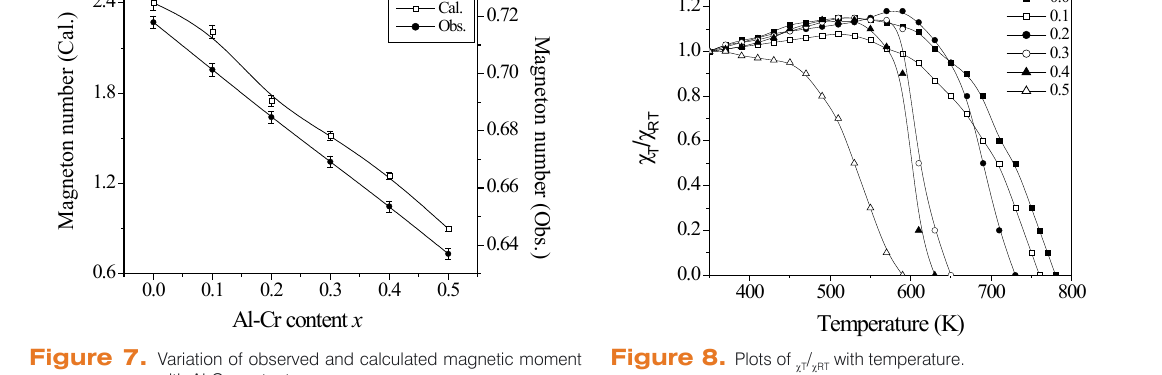
Figure 7. Variation of observed and calculated magnetic moment with Al-Cr content x.